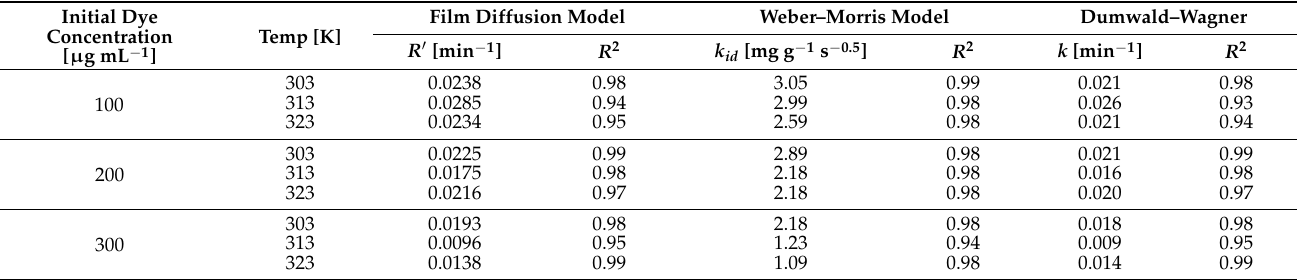
Table 6. The parameters used in the diffusion models.